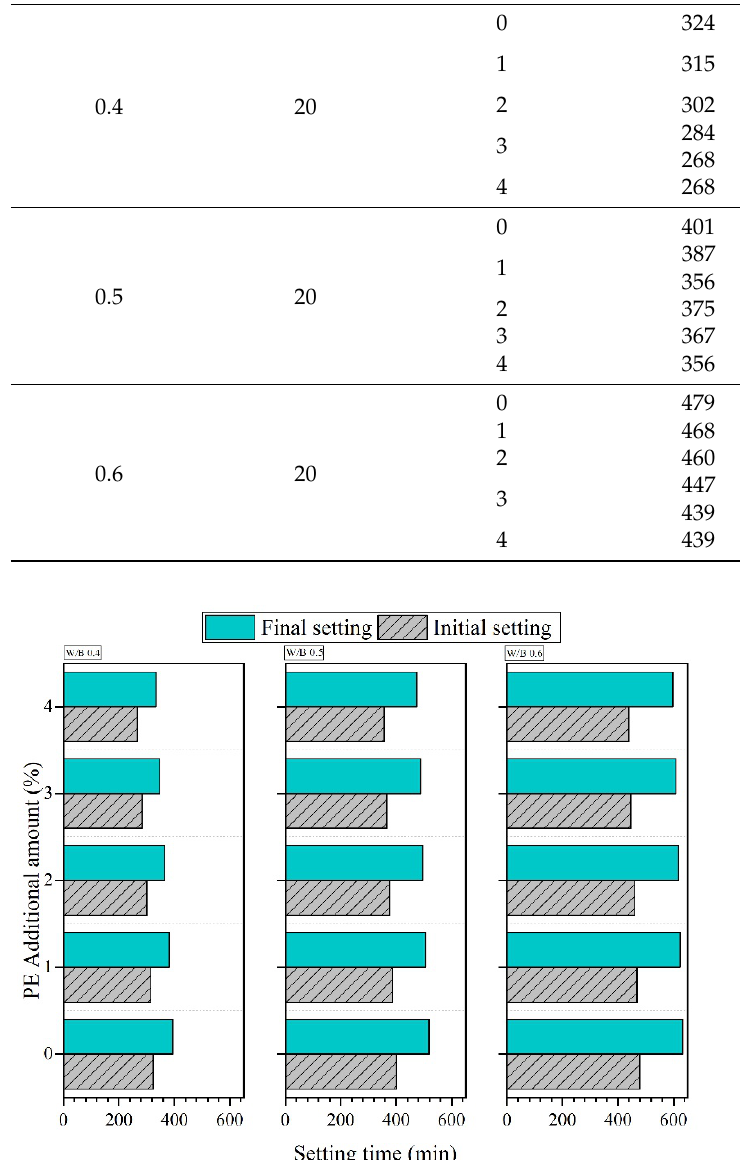
Figure 4. Setting time of cement mortar with different W/B ratios and waste PE.